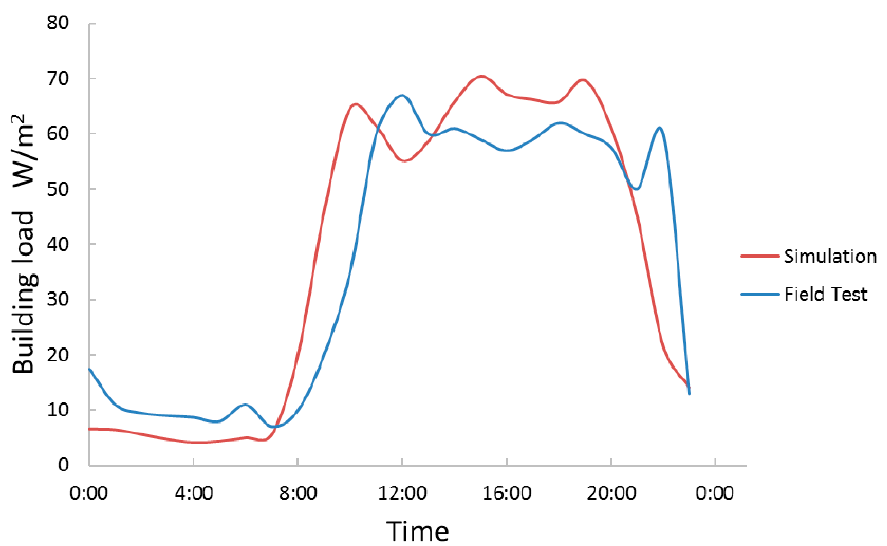
Figure 4. Operating schedules of S1–S12.